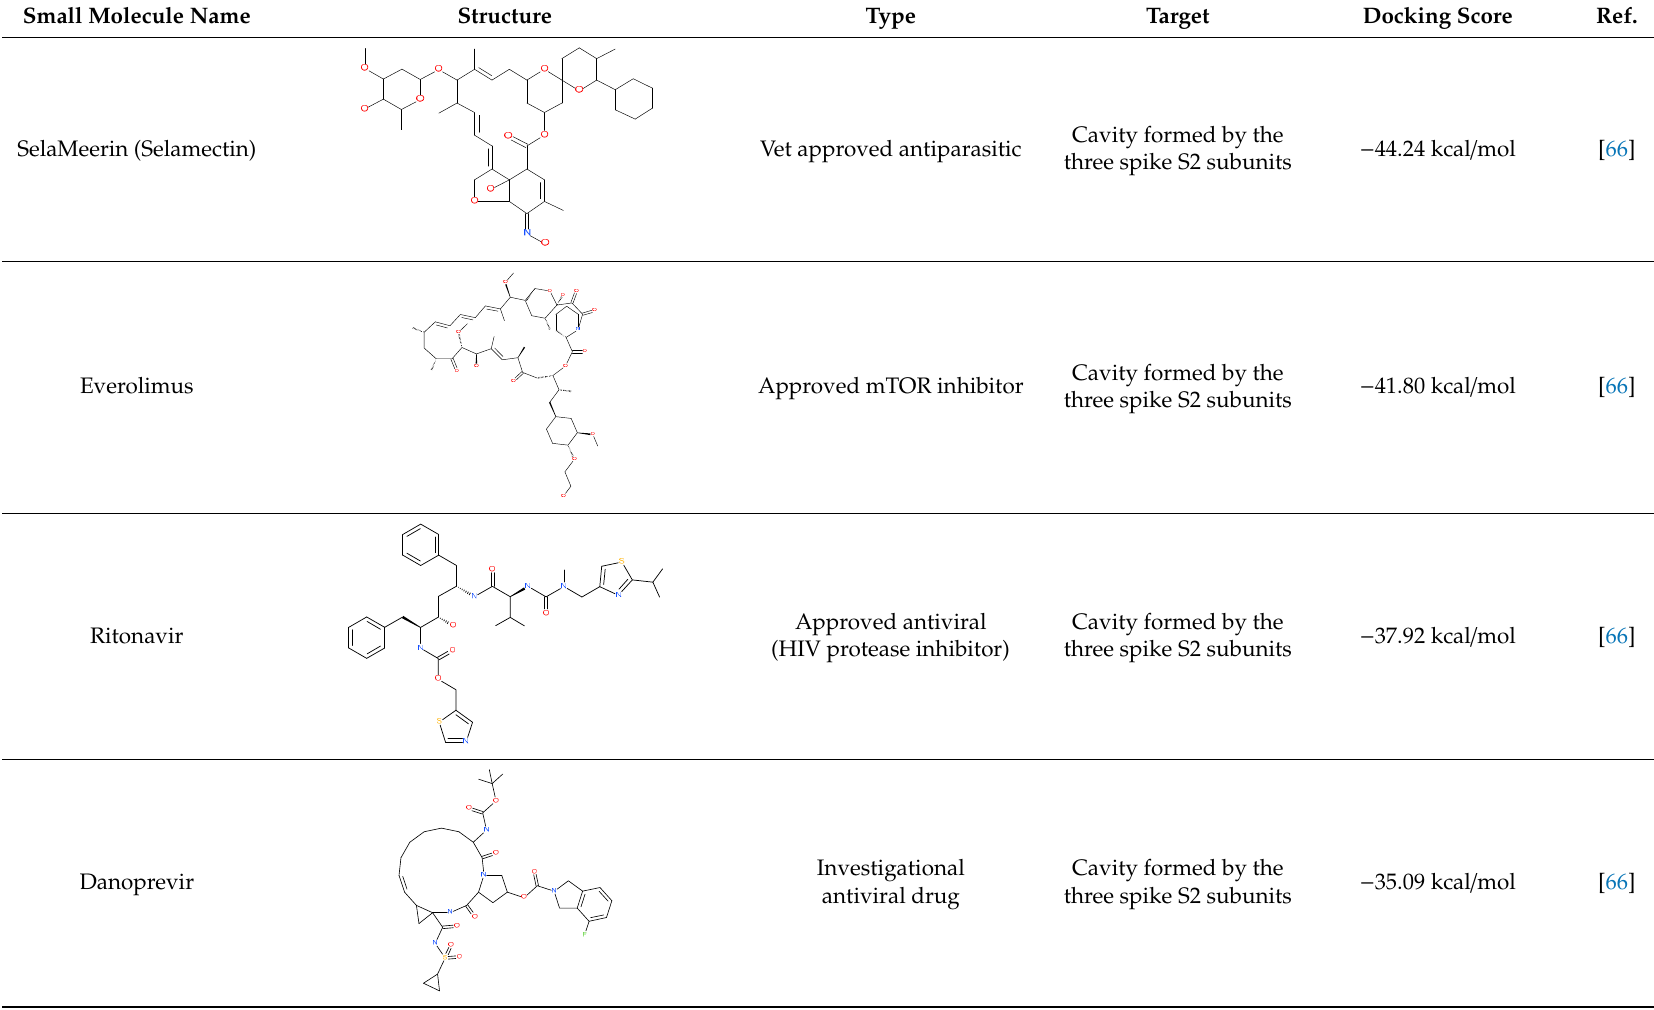
Table 4. Small molecules identified through experimental approaches for targeting host cell proteases and ACE2.